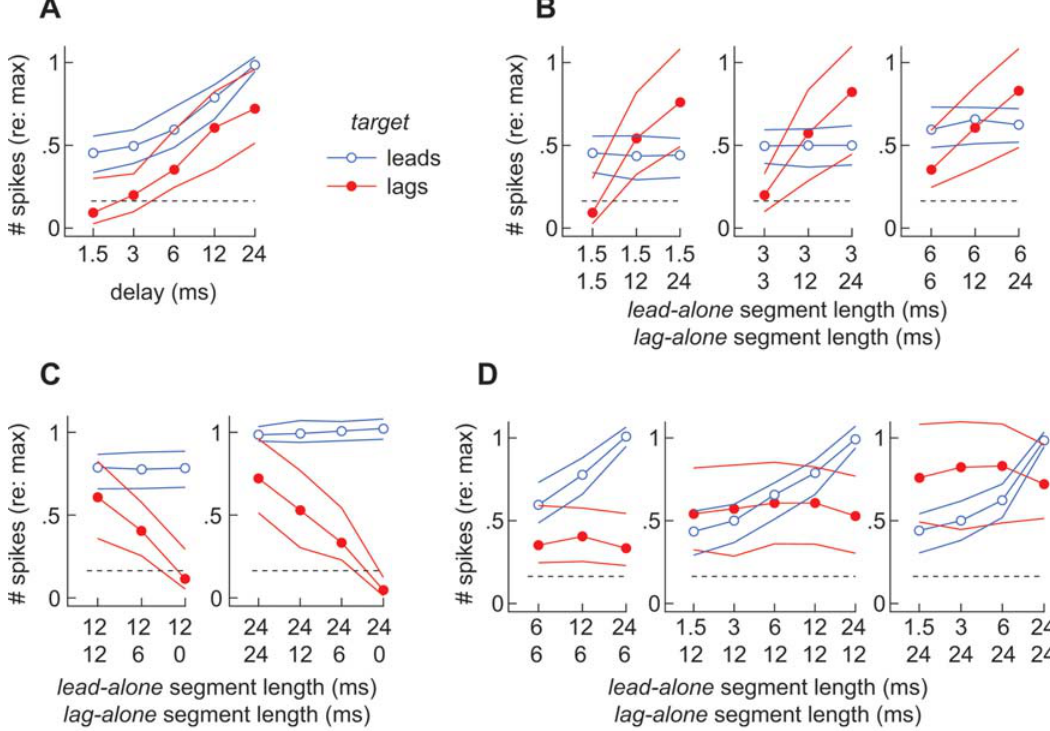
Figure 4. Summary of overall neural responses to lead and lag targets . ( A ) Responses evoked in the standard paradigm in which lead-alone and lag-alone segments were of equal length. ( B ) Responses evoked when lag-alone segments were experimentally lengthened. At each point along the abscissa, the number on top indicates the length of the lead-alone segment. The number underneath indicates the length of the lag-alone segment. ( C ) Responses evoked when lag-alone segments were experimentally shortened. ( D ) Responses shown here have been regrouped so that the length of the lag-alone segment is constant within each panel. All data points represent the median number of spikes evoked when the target led (blue lines) or lagged (red lines). Thin lines indicate the first and third quartiles of each response. Each value is normalized to the average response evoked, in each cell, by 30 ms sounds ( . 50 repetitions) presented from the center of its SRF [11]. The dashed horizontal line represents the median response evoked by two, simultaneous, uncorrelated, noise-bursts from target and masker loci.